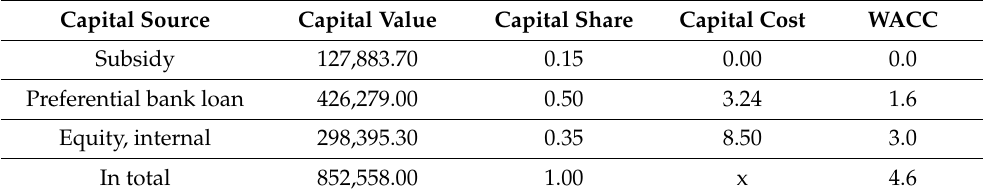
Table 16. Sources of capital, their value, structure, and cost, as well as the weighted average cost of capital financing the project. Source: designed by